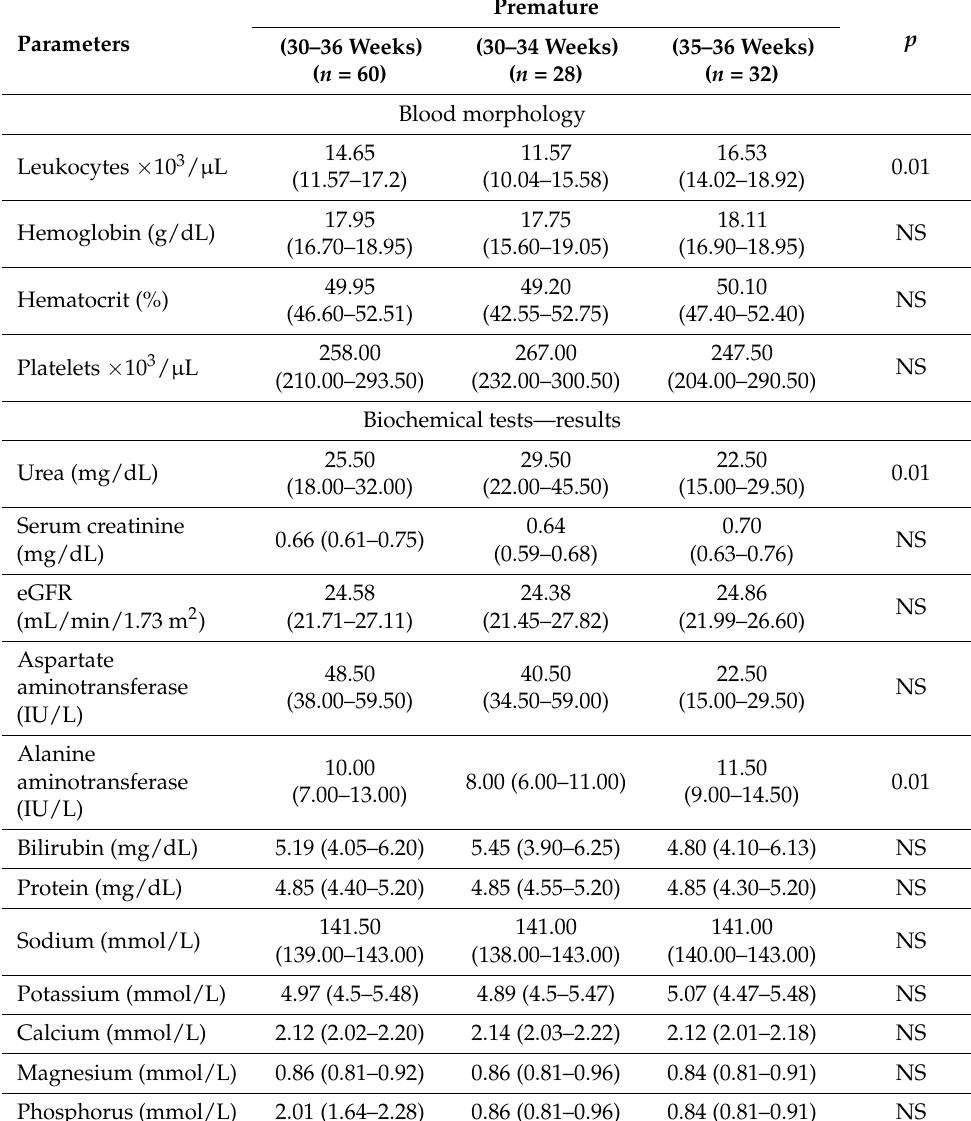
Table 2. Basic laboratory results of premature